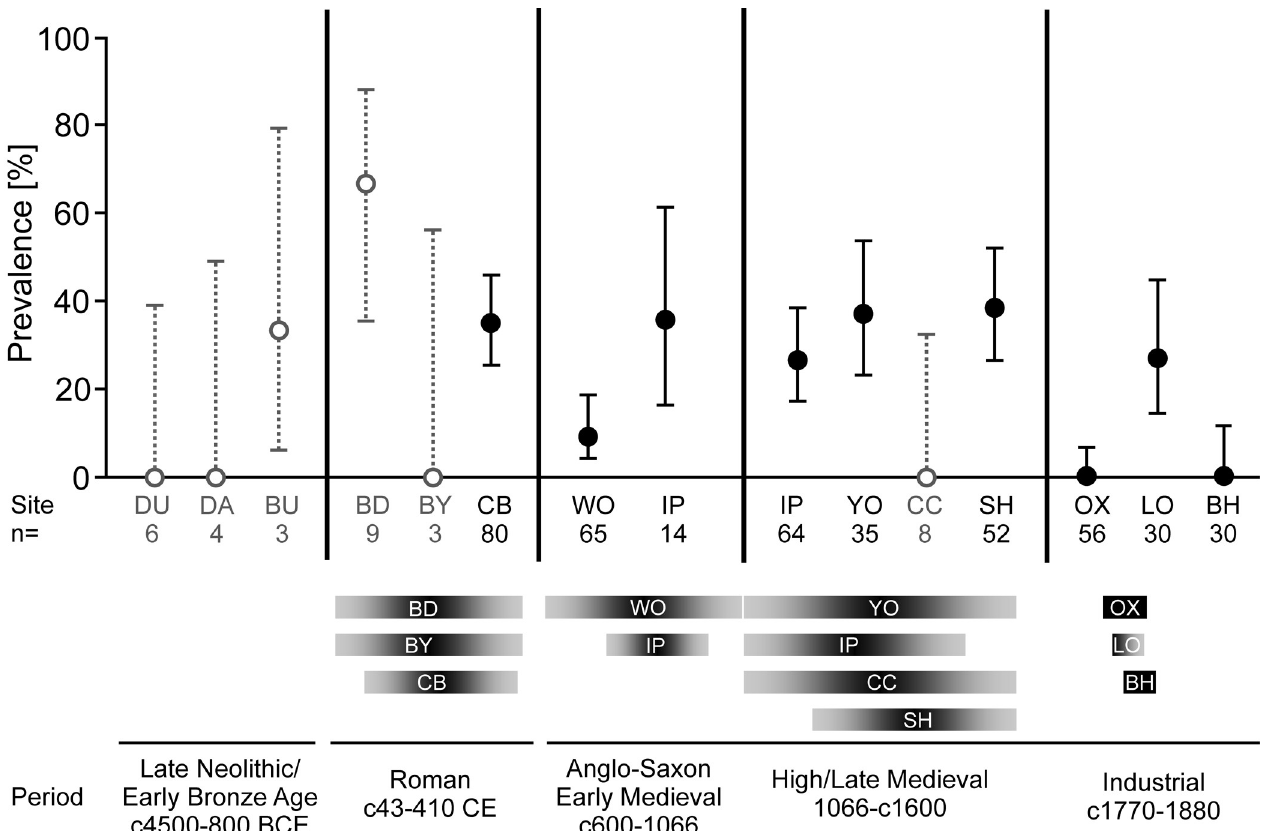
Fig 3. Variation of Ascaris prevalence rates in different sites. The prevalence of Ascaris in skeletal individuals from fifteen sites (group size n > 1) across the five time periods is displayed with a 95% confidence interval (Wilson Confidence Interval). Sites with very few samples ( < 10) provide a less reliable estimate for the prevalence and are thus displayed in grey. The sites included are Durrington, DU, Datchet, DA, and Bulford, BU (Late Neolithic/Early Bronze Age); Bleadon, BD, Bletchingley, BY, and Canterbury, CB (Roman); Worcester, WO, and Ipswich (Anglo-Saxon/Early Medieval); Ipswich, IP, York, YO, Christchurch, CC, and Southampton, SH (High/Late Medieval); Oxford, OX, London, LO, and Birmingham, BH (Industrial). The dating range for the sites is visualized by the horizontal bar chart below, with a continuous time axis from the Anglo-Saxon (Early Medieval) to the Industrial periods. The dates for the earliest samples are not displayed as they are labelled Late Neolithic/Early Bronze Age (DU/DA) or Bronze Age (BU).